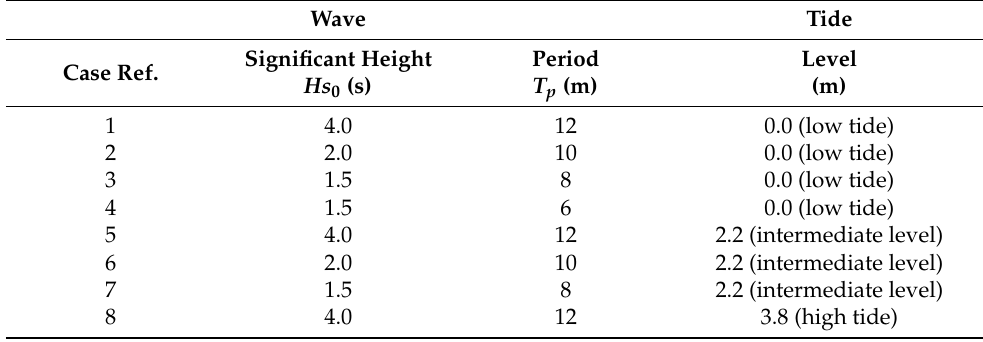
Table 2. Specification of the hydrodynamic cases considered. Wave Tide Case